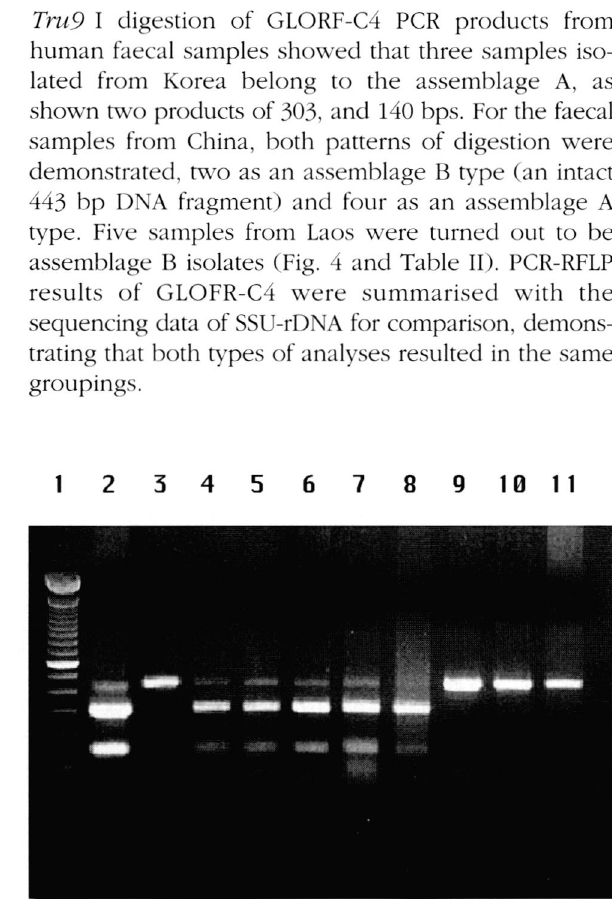
Fig. 4. - PCR-RFLP analysis of GLORF-C4 isolated from human faecal samples. The GLORF-C4 DNA fragments amplified from various iso­ lates were digested with Tru9 I endonuclease. Lane 1, 100 bp ladder; lane 2, WB (assemblage A): lane 3. GS (assemblage B); lane 4-6, the Korean sample. KP. KL. KC2; lane 7-9, the Chinese samples. CA13. CA1 I. CAP: lane 10-11. the Laos samples. RD2S. and RE19.